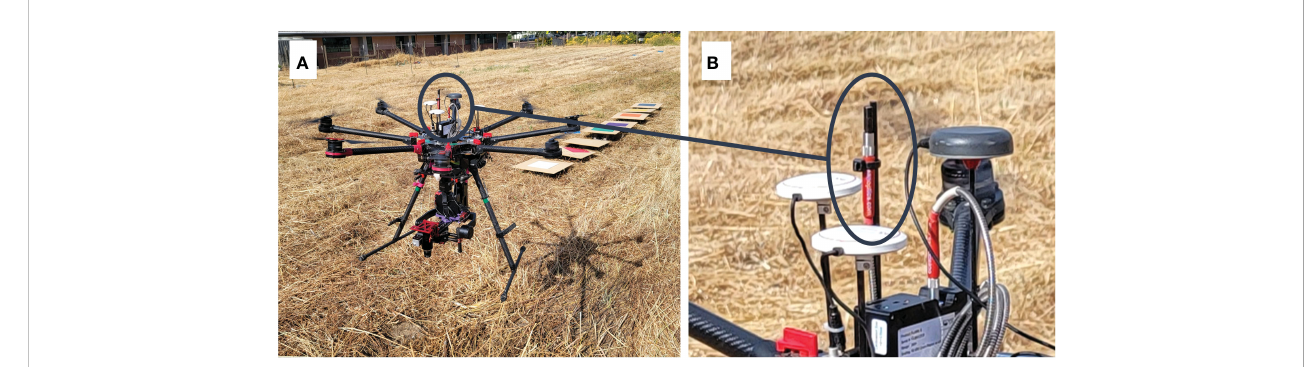
FIGURE 1 Octocopter drone system used in this study (A) with down-welling irradiance sensor (B)